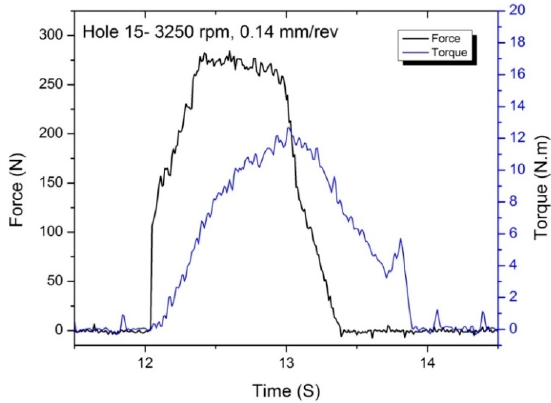
Figure 5. Thrust and torque profiles of drilling a hole at 3250 rpm and 0.14 mm/rev.